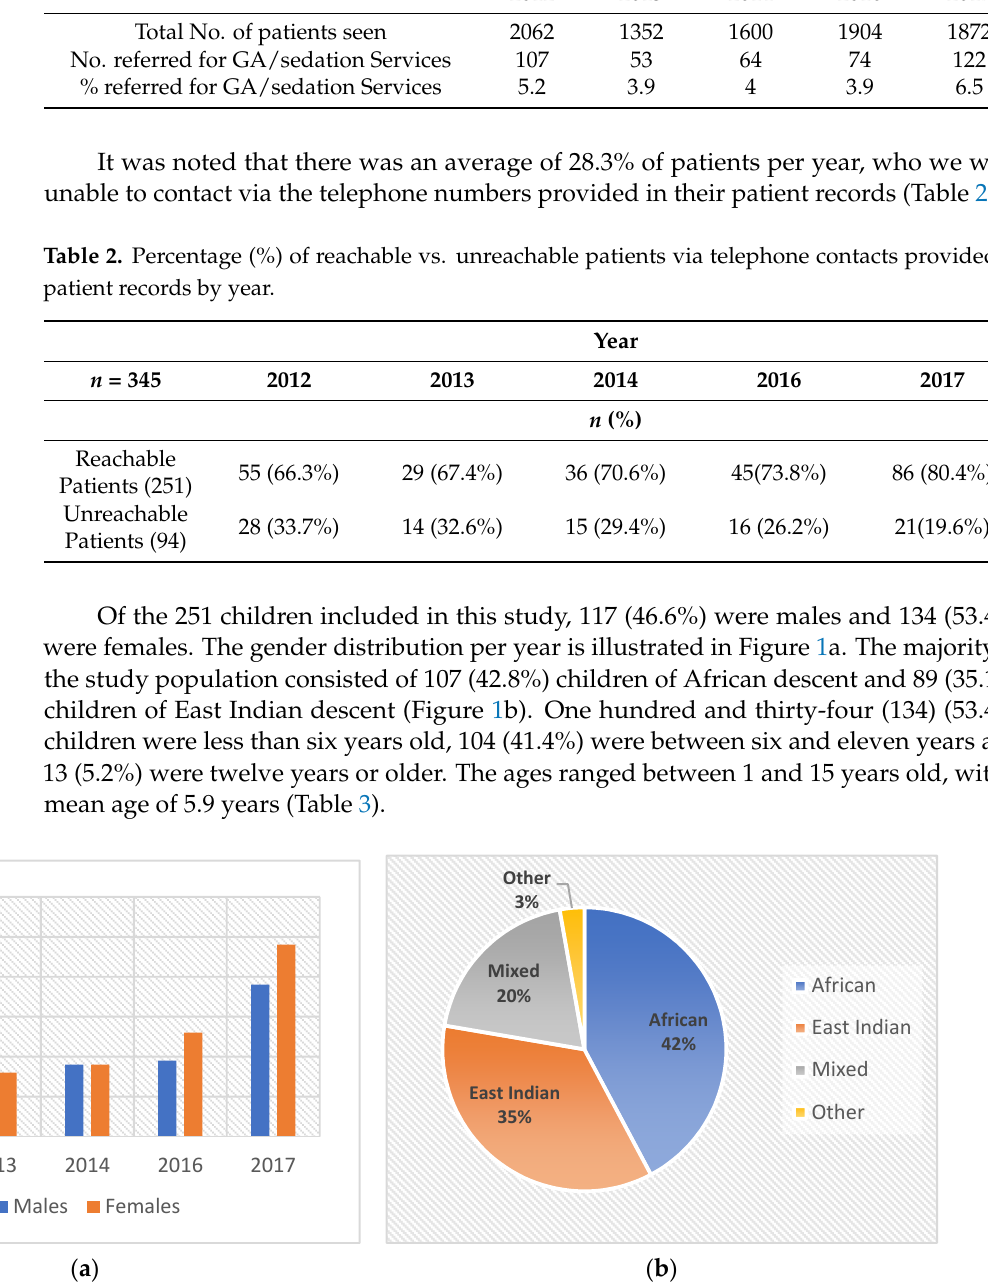
Table 1. Number of patients seen at the CDHU emergency clinic and the percentage referred for GA/sedation services by year.